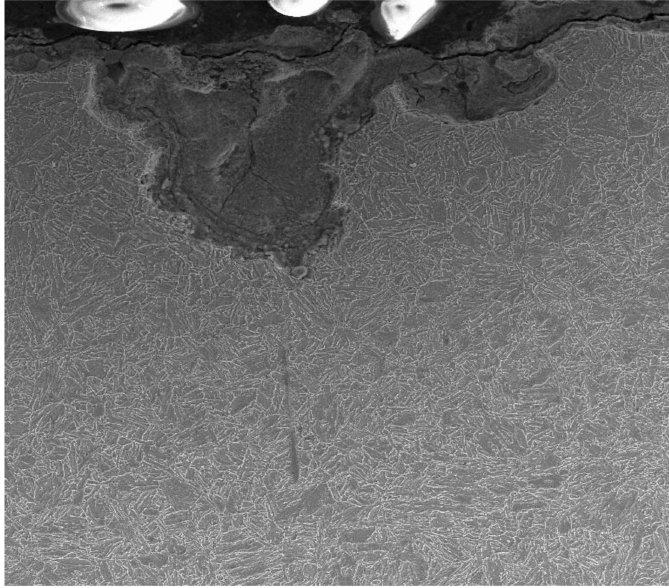
Figure 5. Cross section of L80-1 sample exposed to 95 ◦ C (a long sample). Table 3. EDS analyses for the sample indicated in Figure 6, the sample L80-1 exposed to 95 ◦ C.